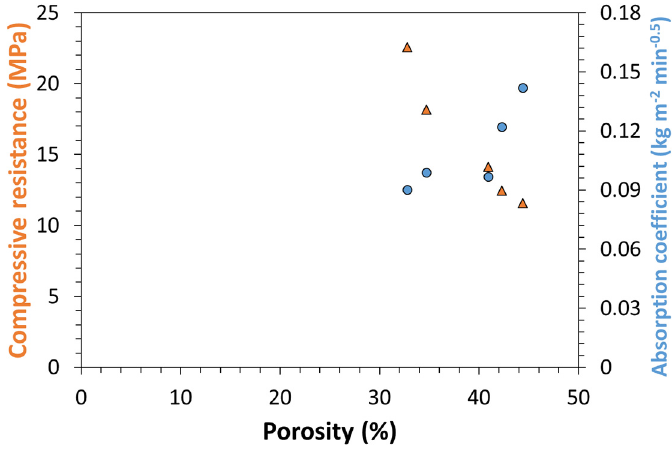
Figure 16. Compressive strength and absorption coefficient versus material total porosity.